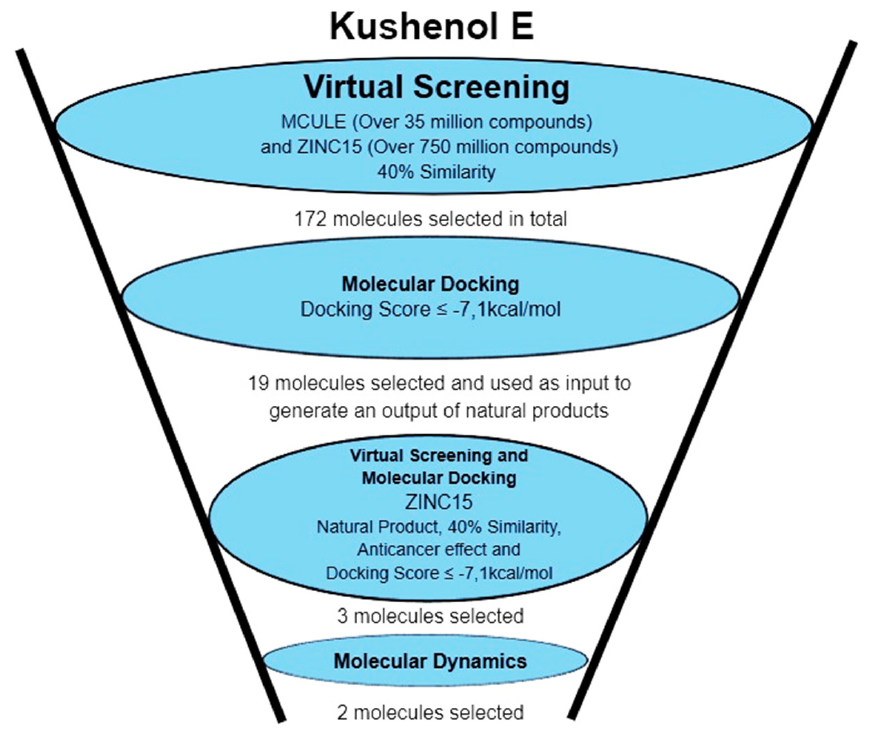
Figure 6. Workflow of ligand-based and structure-based virtual approaches.